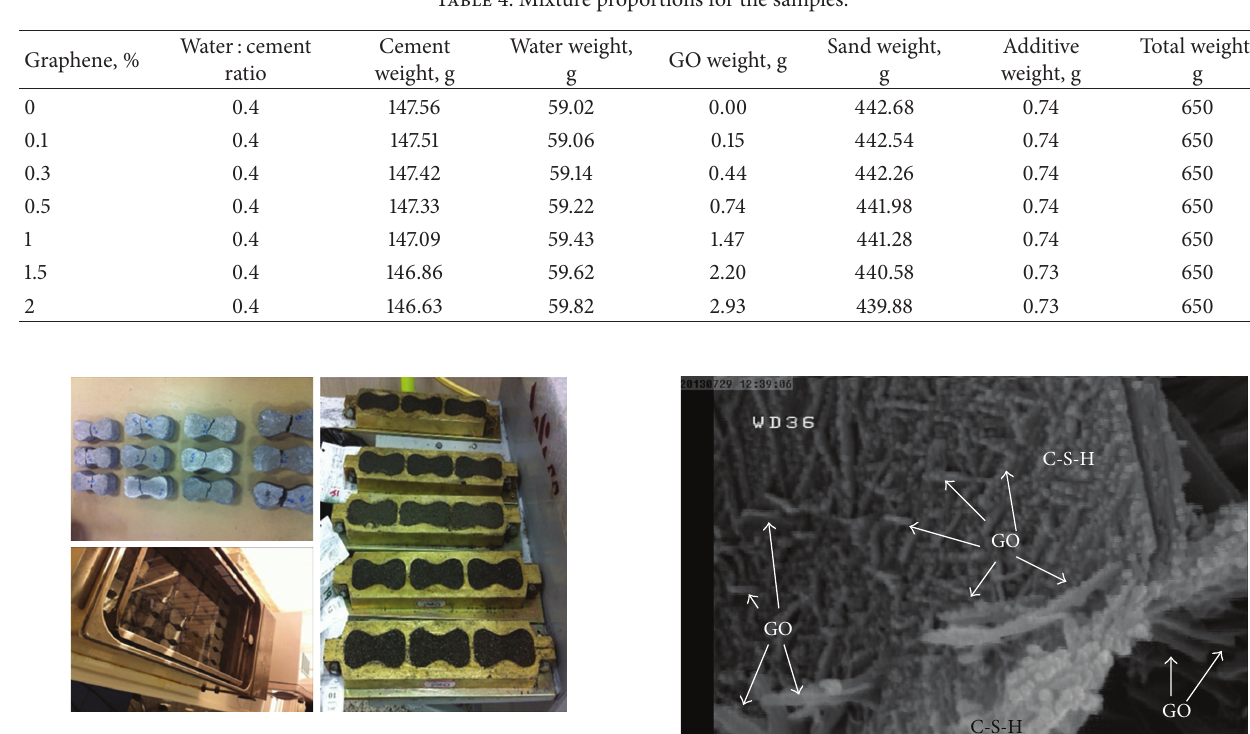
Figure 6: Samples and sample molds used for tensile strength test ASTM C307.